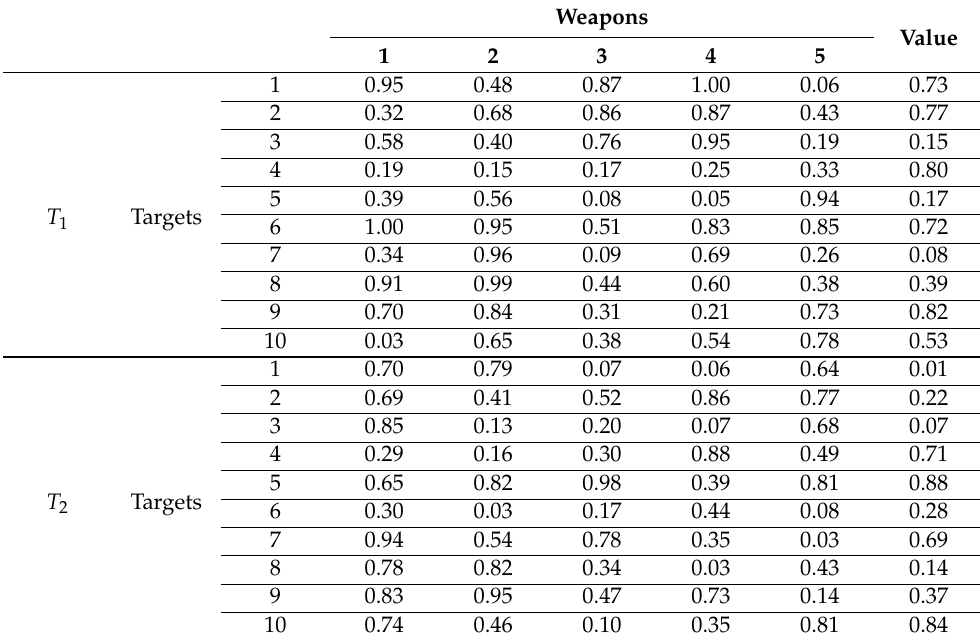
Table A7. Details of the destructive value of every target and the probability of kill for every weapon in the two component tasks of problem 7 in Table 2. Each task is a WTA problem.